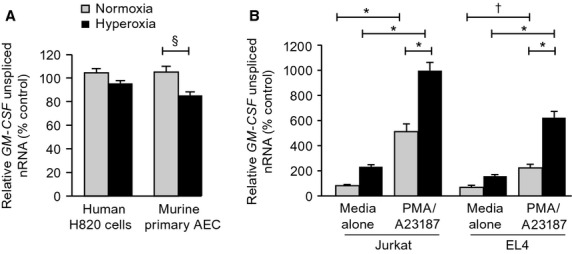
Effect of exposure to hyperoxia on GM-CSF transcription rate. Lung epithelial cells (A) and T cells (B) were exposed to normoxia (gray bars) or hyperoxia (black bars) for 48 h in control medium. The relative rate of transcription of GM-CSF was determined by real-time PCR using primers designed to span the junction of Exon 1/Intron A of human and murine GM-CSF genes (see Methods). Values are normalized to rate of expression of RNu6 nRNA. Data are expressed as mean ± SEM, n = 3. The experiment shown is representative of two independent experiments. §P = 0.027; *P <0.001; †P < 0.05.